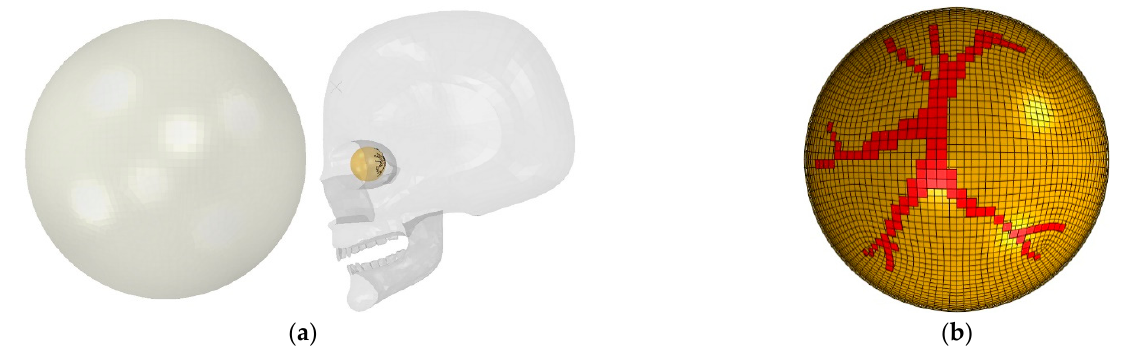
Figure 2. Finite element model of soccer ocular injuries. ( a ) Initial setup of a flying soccer ball hitting the face, including the eyeball; ( b ) retinal vessels in the posterior retina (frontal view).